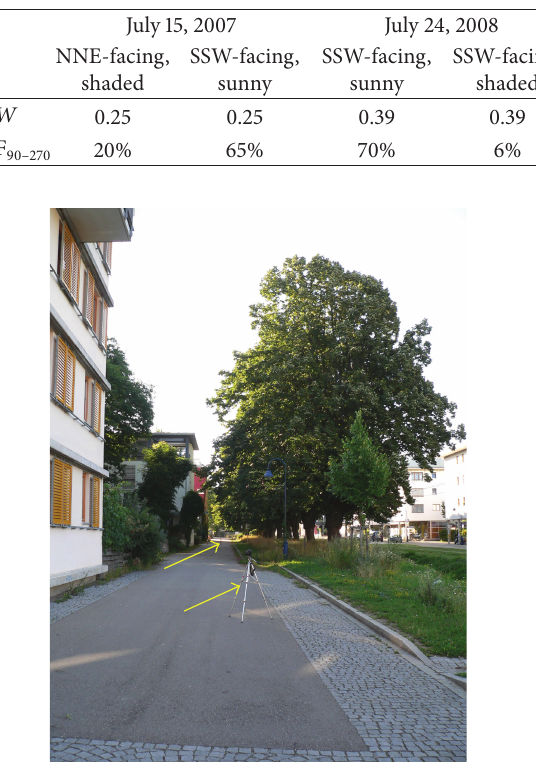
Figure 3: Human-biometeorological measuring sites at the sunny (in the front) and shaded (at the back) SSW-facing sidewalk of a WNW street canyon in Freiburg, “Vauban” quarter, July 24,